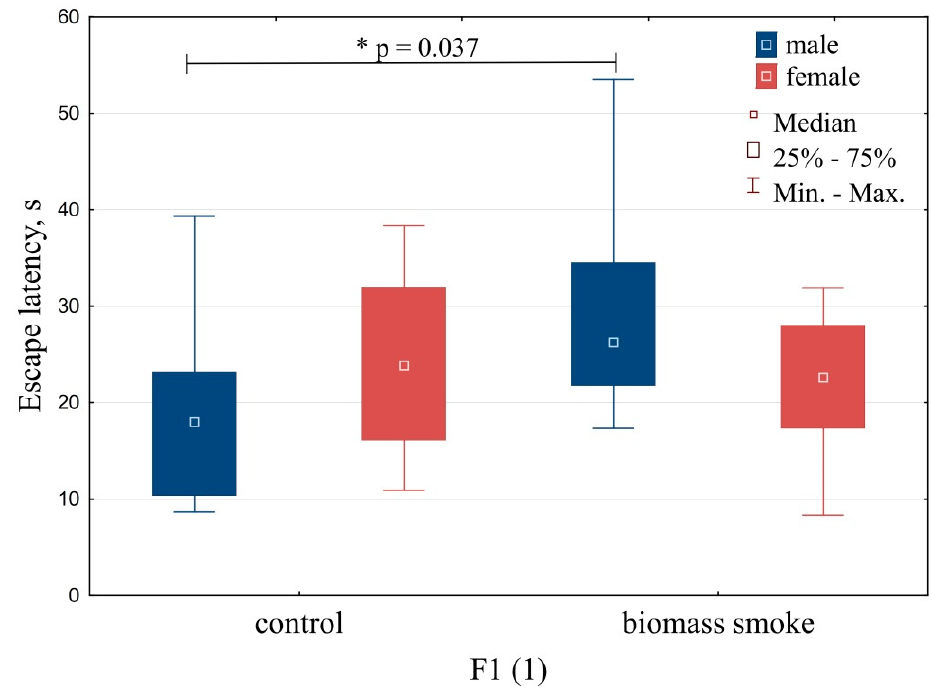
Figure 4. Test results in the Morris water maze. Offspring born by mating immediately after exposure. Note: * the differences statistically significant compared to the control at p < 0.05.